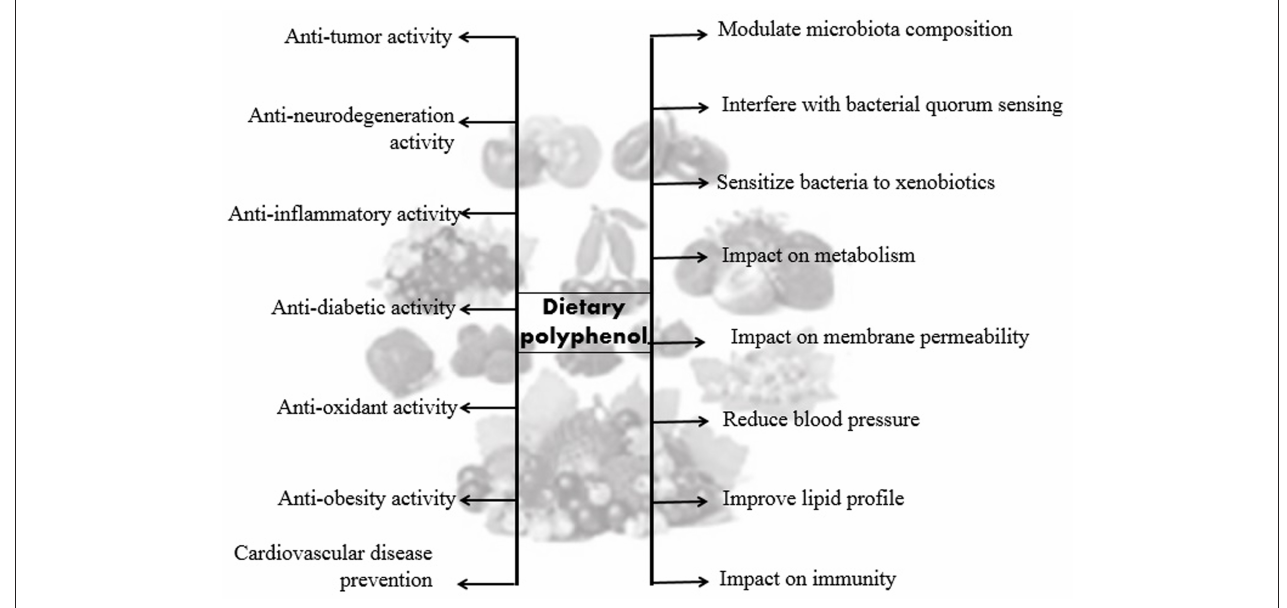
FIGURE 4 | Beneficial effects of dietary